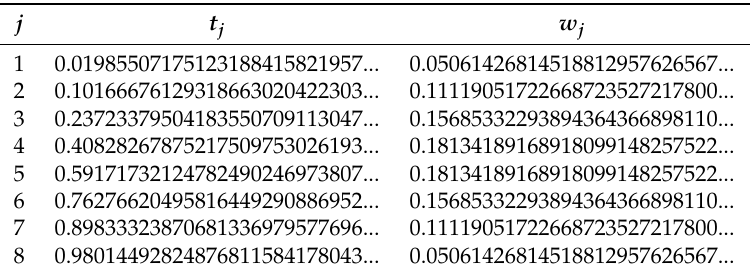
Table 5. (Abscissas and weights for t =